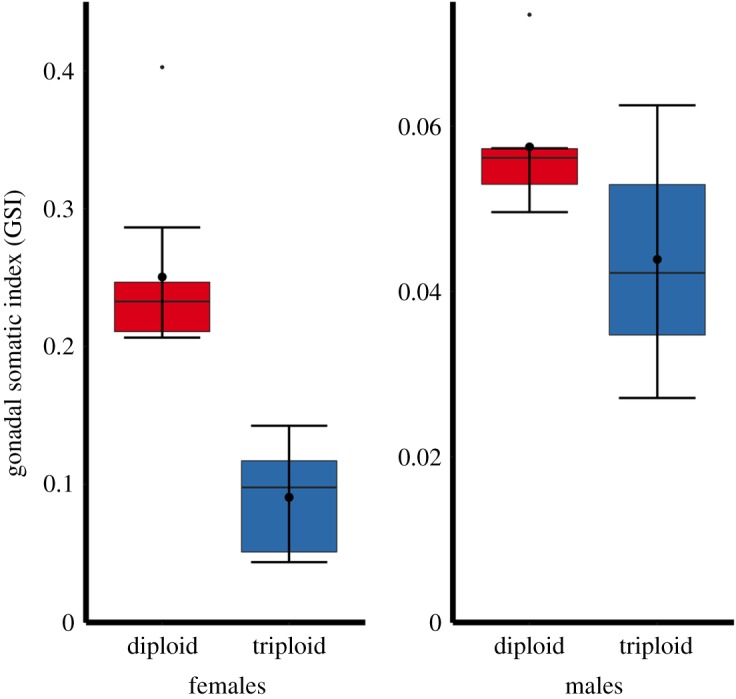
Gonadal somatic index of 2-year-old female and male triploid (n = 15) and diploid (n = 15) farmed Atlantic salmon. Boxplots show median (horizontal black line) and mean (thick black dot); whiskers indicate points within the 1.5 IQR and quartile ranges (coloured box area).